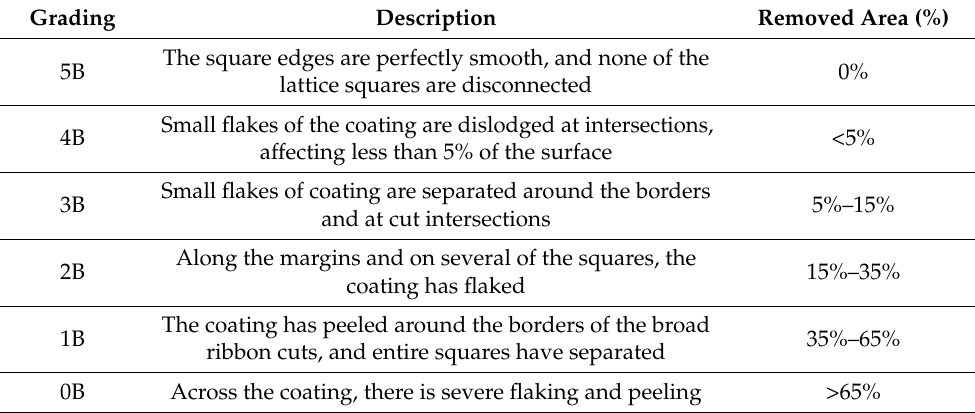
Table 2. Scratch adhesion grading scale according to the ASTM D 3359